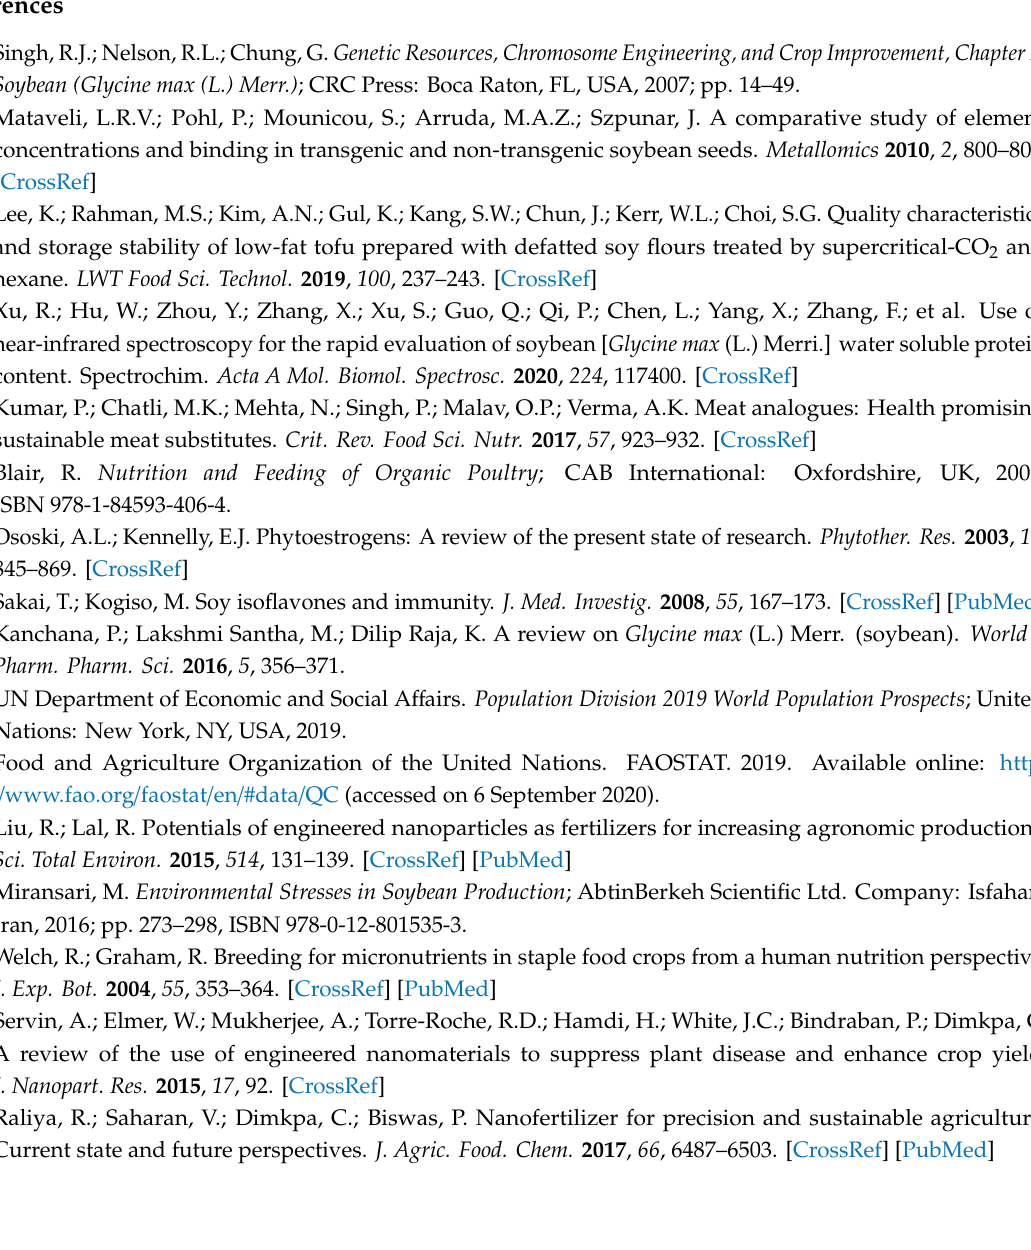
Figure S1: Variation in dry weight in root, stem, leaf and seed, Table S1: soil physiochemical properties, Table S2: statistical analysis of Cu uptake in various